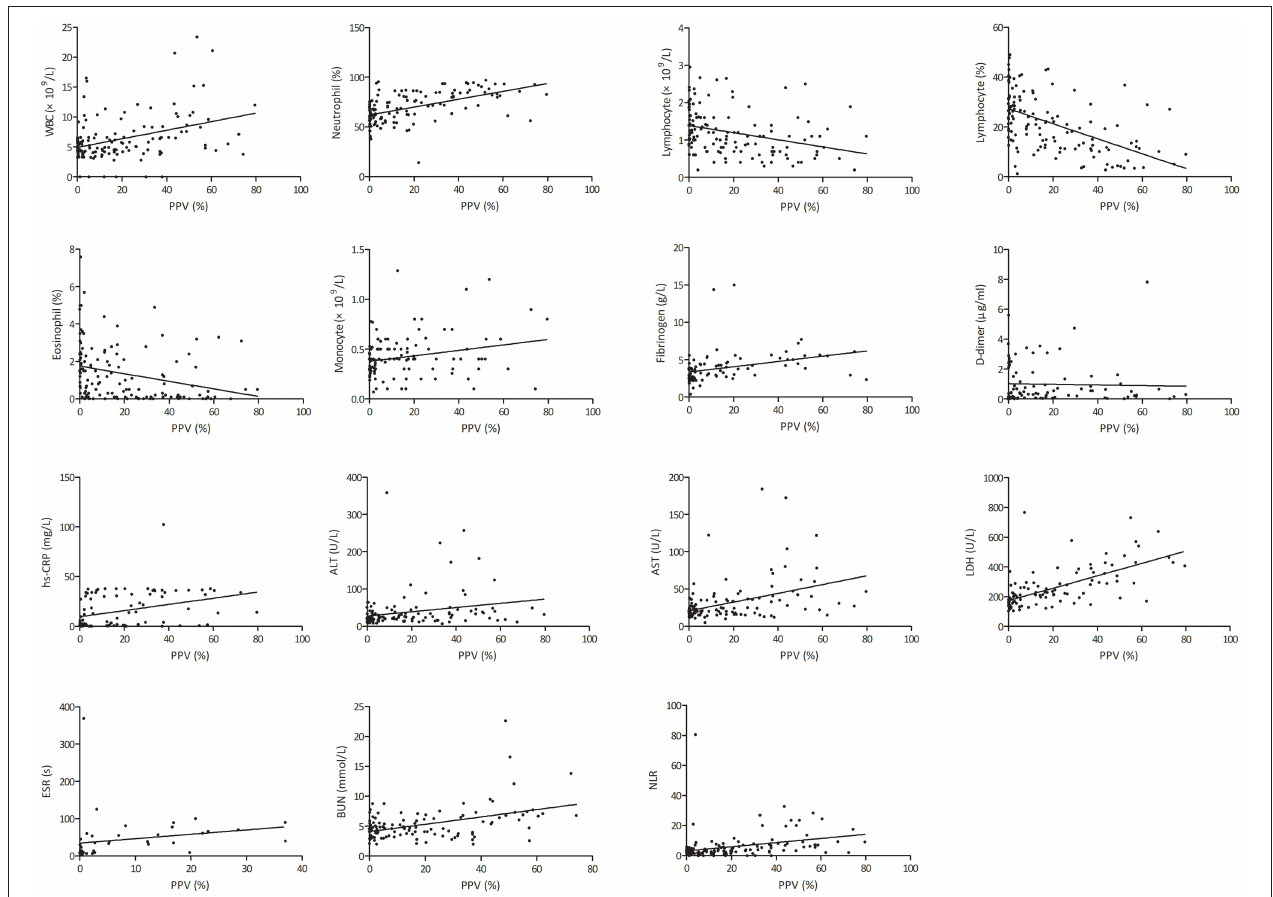
FIGURE 6 | Correlation of total pneumonia volume with different clinical parameters. hs-CRP, high-sensitivity C-reactive protein; ALT, alanine transaminase; AST, aspartate aminotransferase; LDH, lactic dehydrogenase; NLR, neutrophil-to-lymphocyte ratio; PPV, percentage of pneumonia